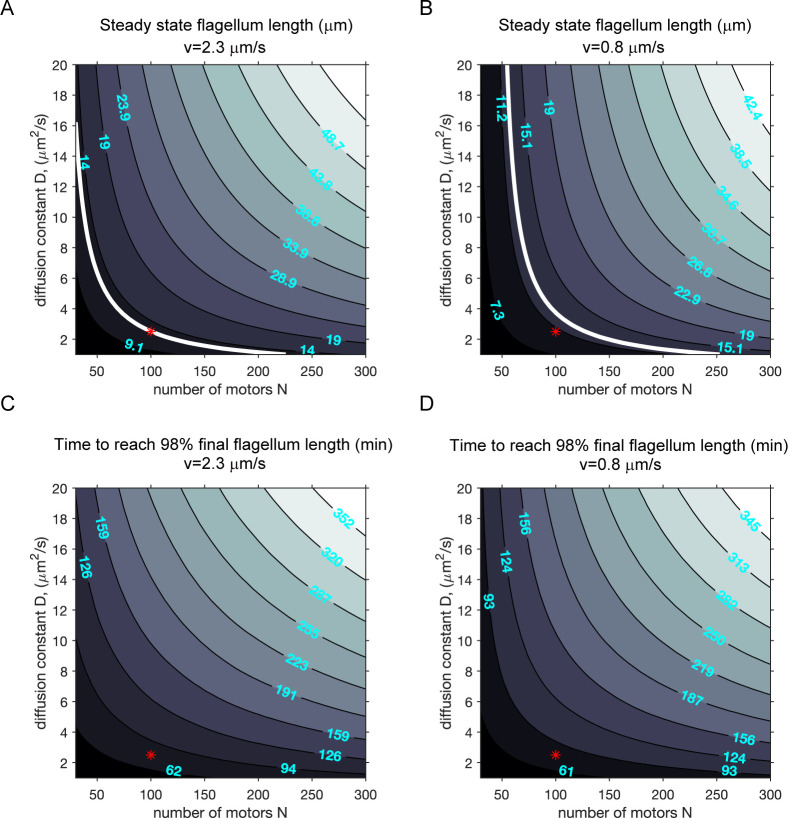
Modeling (case 1): the effect of diffusion constant and the number of motors on ciliary length and the timescale to reach final ciliary length.(A–B) Contour plots of the steady-state cilium length when N, the total number of motors, is varied with the rate of diffusion (D) at two different motor speeds, when only motors are limiting (case 1). (A): fast IFT. (B): slow IFT. All other parameters were kept constant. The white contour lines correspond to 12.5 μm (assumed to be the wild-type cilium length). Red markers correspond to parameters used in the simulations presented in the main text. (C–D) Contour plots of the growth time (in minutes) required to attain 98% of the final steady-state flagellum length.